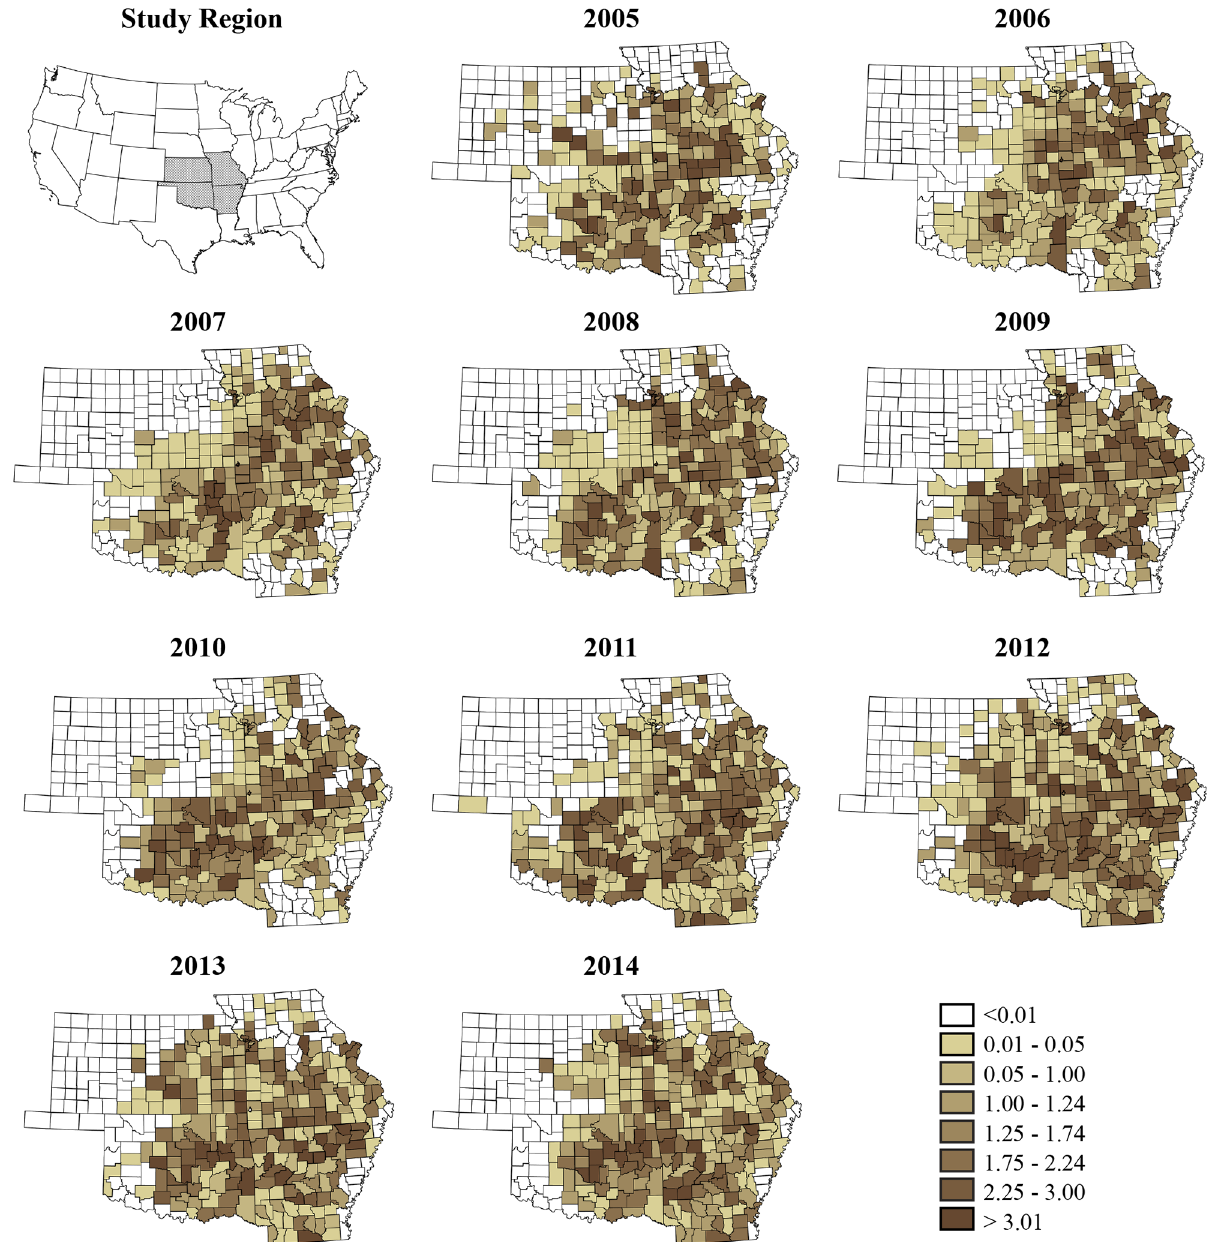
Fig 4. County – specific Bayesian smoothed estimates (posterior median) of Rocky Mountain spotted fever prevalence for the study period between years 2005 – 2014.